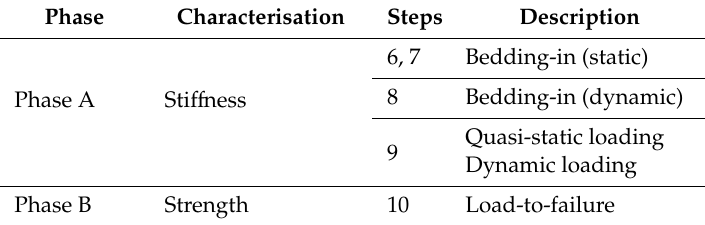
Figure 5. Schematic of test sequence (adapted from ISO standards [20]). Table 4. Description of constituent steps of ISO18692:2007 in Phase A and Phase B.